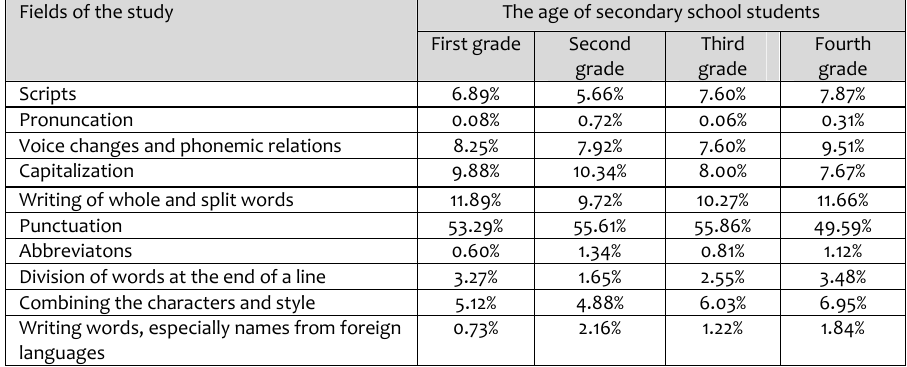
Table 4 Overview of the percentage of different types of orthographic mistakes in written assignments of secondary school students in respect to the age of secondary school